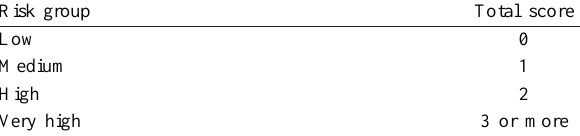
Table 3. Risk group class according to the score Risk group